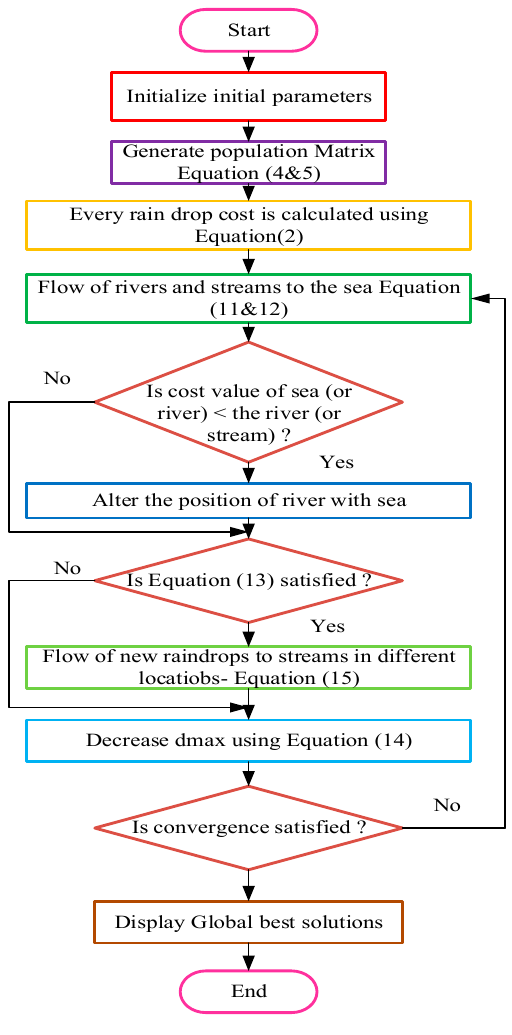
Figure 6. WCA approach flowchart.